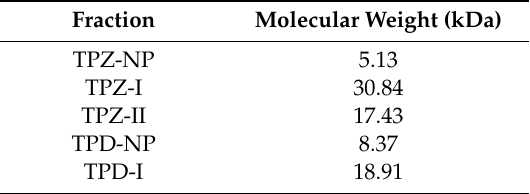
Table 2. The molecular weight of polysaccharides from two truffle species.